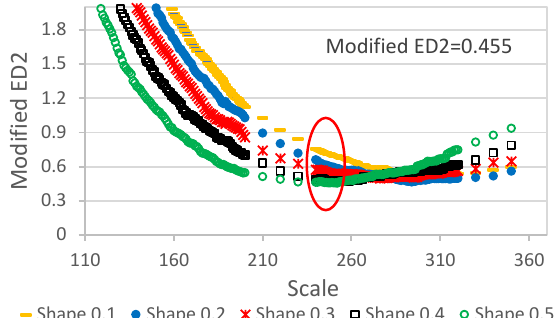
Aguilar et al. (2018) already reported that the application of atmospheric correction (ATCOR) in the VHR orthoimages Figure 3 . Modified ED2 computed by using AssesSeg for MRS resulted in a substantial reduction in the quantitative range of outputs from Deimos-2 MS orthoimage. values or pixel relative mapping positions available for assigning pixel content (from 1 to 100% in the case of ground reflectance). This numerical effect, together with the mathematical formulation of the fusion factor or threshold employed for grouping pixels in the MRS algorithm, would imply that the higher the range of the pixel mapping content, the larger the number of objects would be segmented for a certain Scale